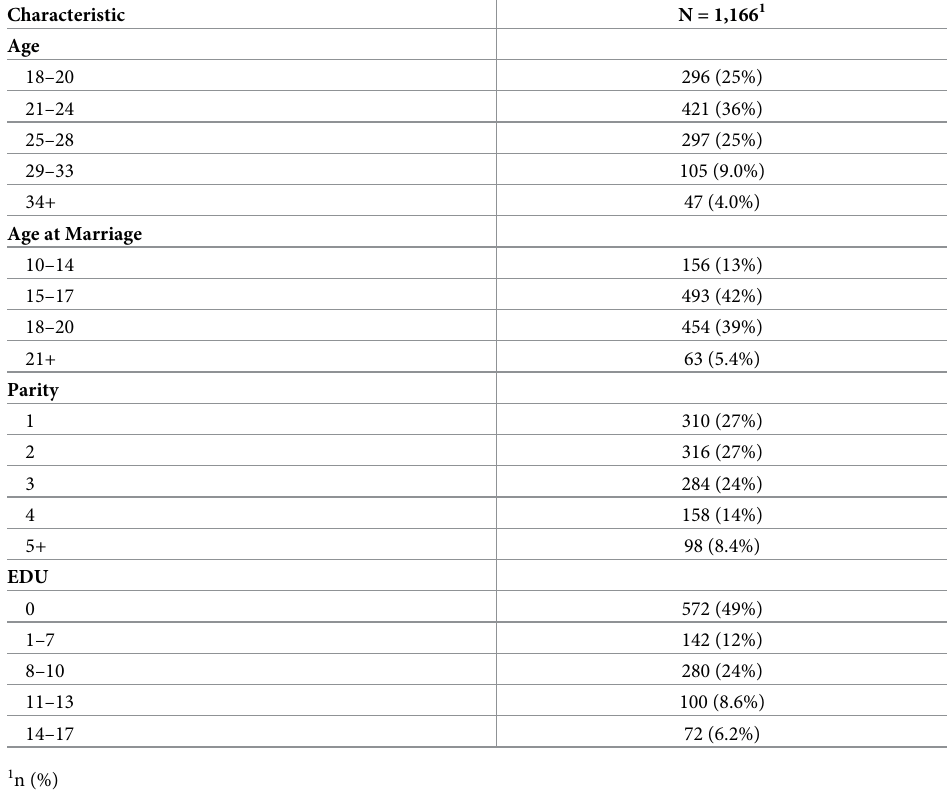
Table 3. Descriptive statistics for categorical control variables used in the regression models